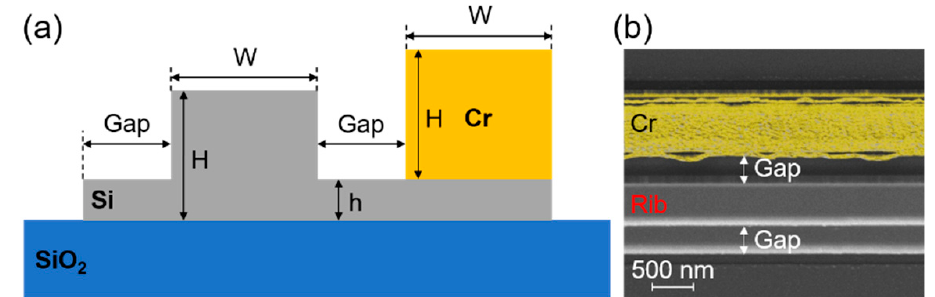
Figure 6. ( a ) Simplified cross-sectional diagram of the phase shifter (type II), not to scale. The parameters are the same as the phase shifter (type I) shown in Figure 1c. ( b ) SEM image of the phase shifter (type II). Cr heater is false colored.